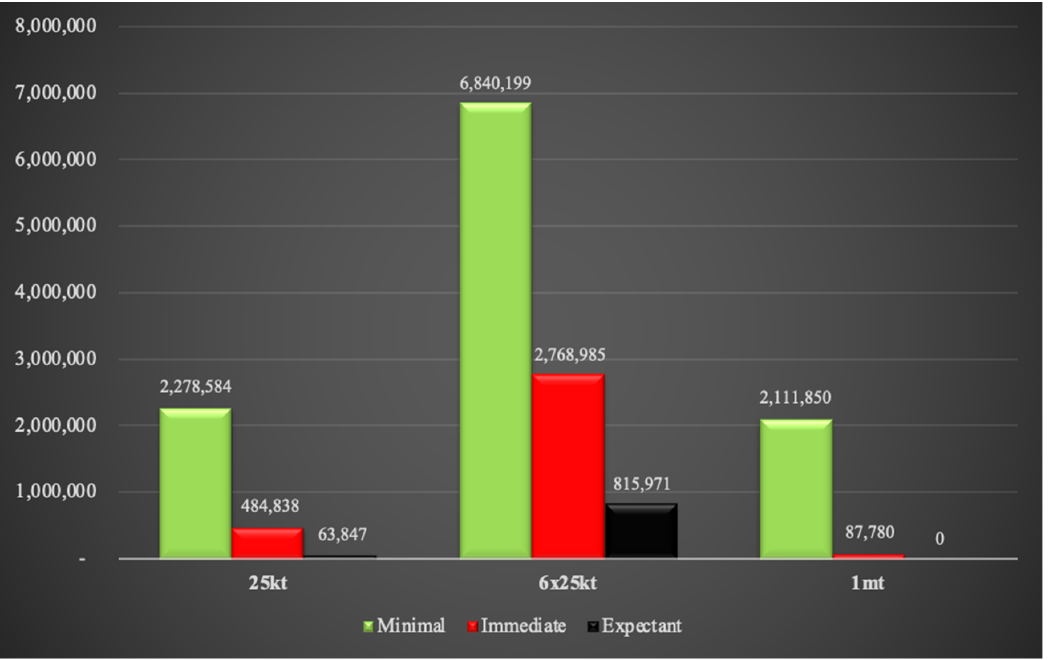
Figure 12. Fallout radiation exposure at 4 h.